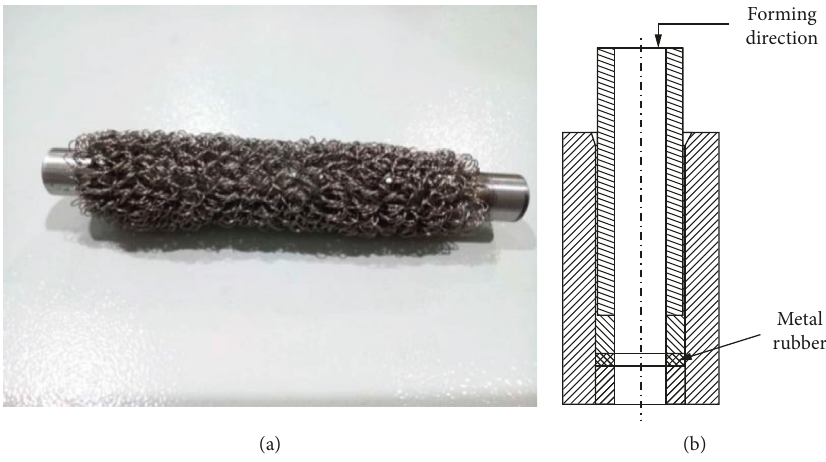
Figure 3: A roughcast of MR wrapped around (a) and the molding diagram of the MR (b).